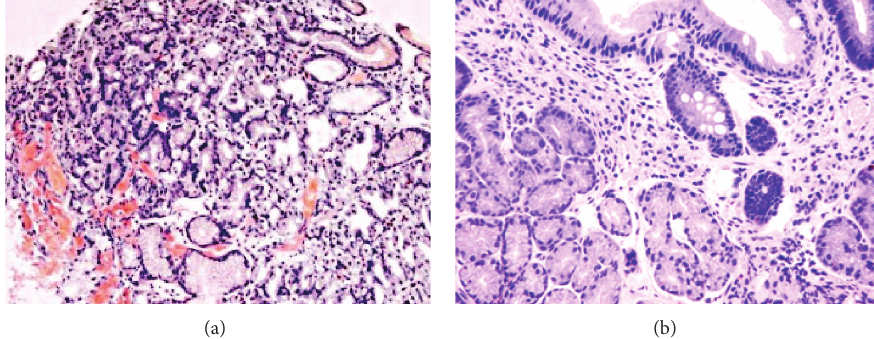
Figure 1: Endoscopic gastric biopsy. (a) Congo red staining shows amorphous amyloid deposits in the gastric mucosa. (b) After 4 years of tocilizumab treatments, regression of the amyloid deposition was noted.